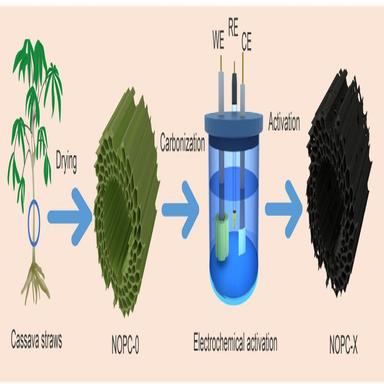
Illustration of the synthesis procedure of the NOPC sample